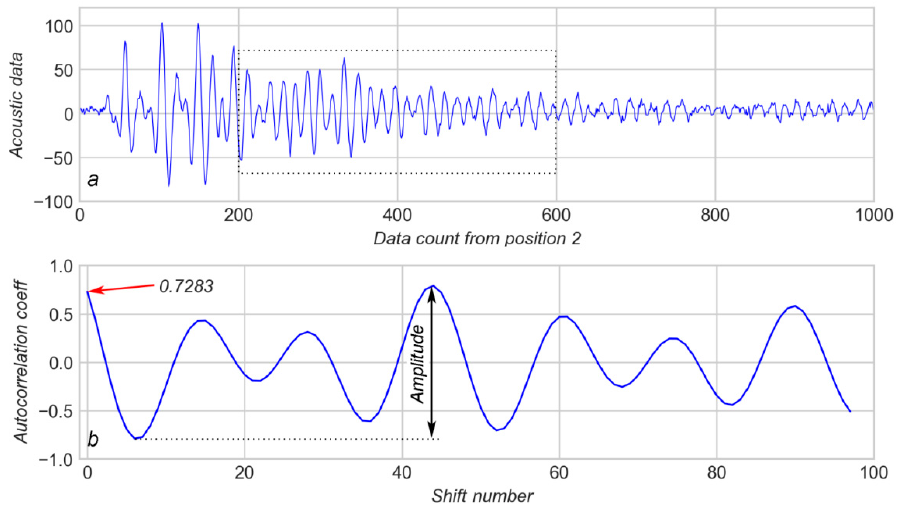
Figure 5. ( a )—1000 K window of acoustic data from arrow 2 (see Figure 1); ( b )—corresponding autocorrelation coefficients.